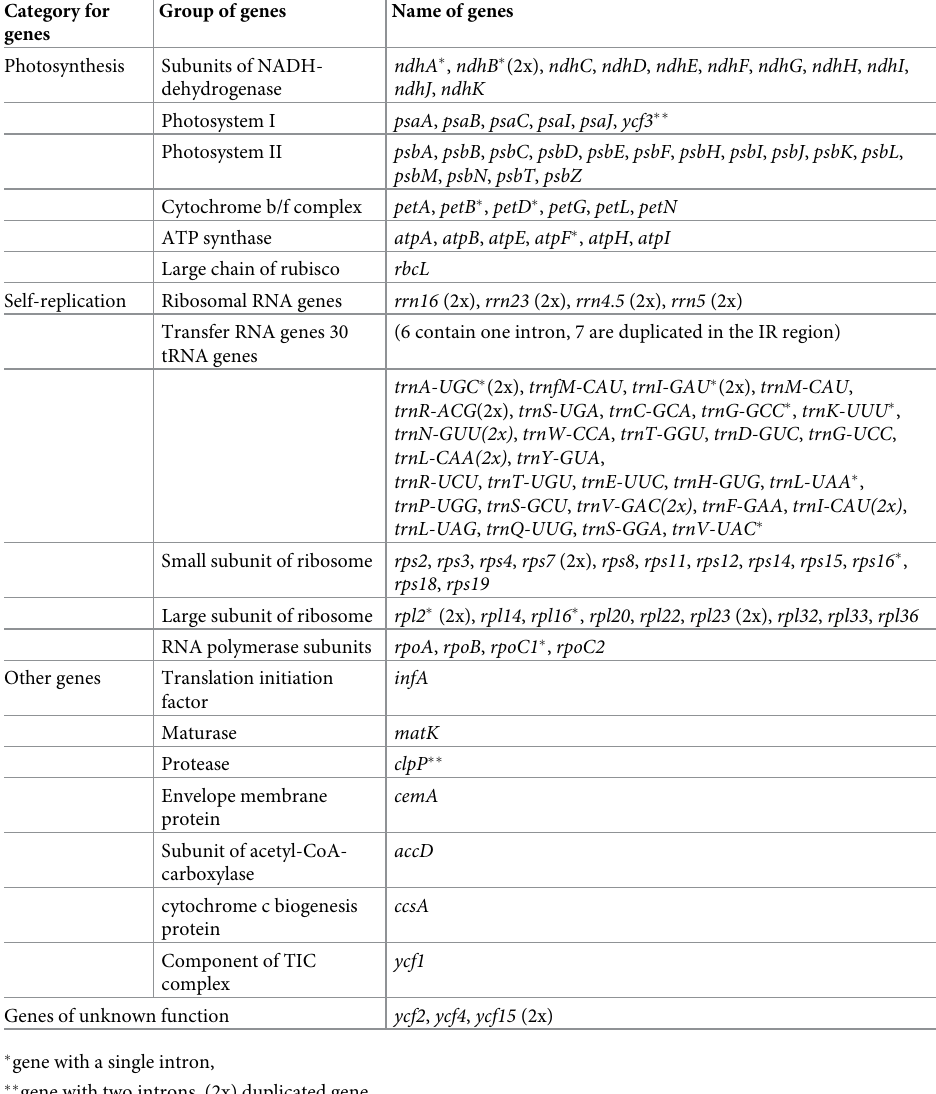
Table 3. The gene functions of the plastomes of 15 species of